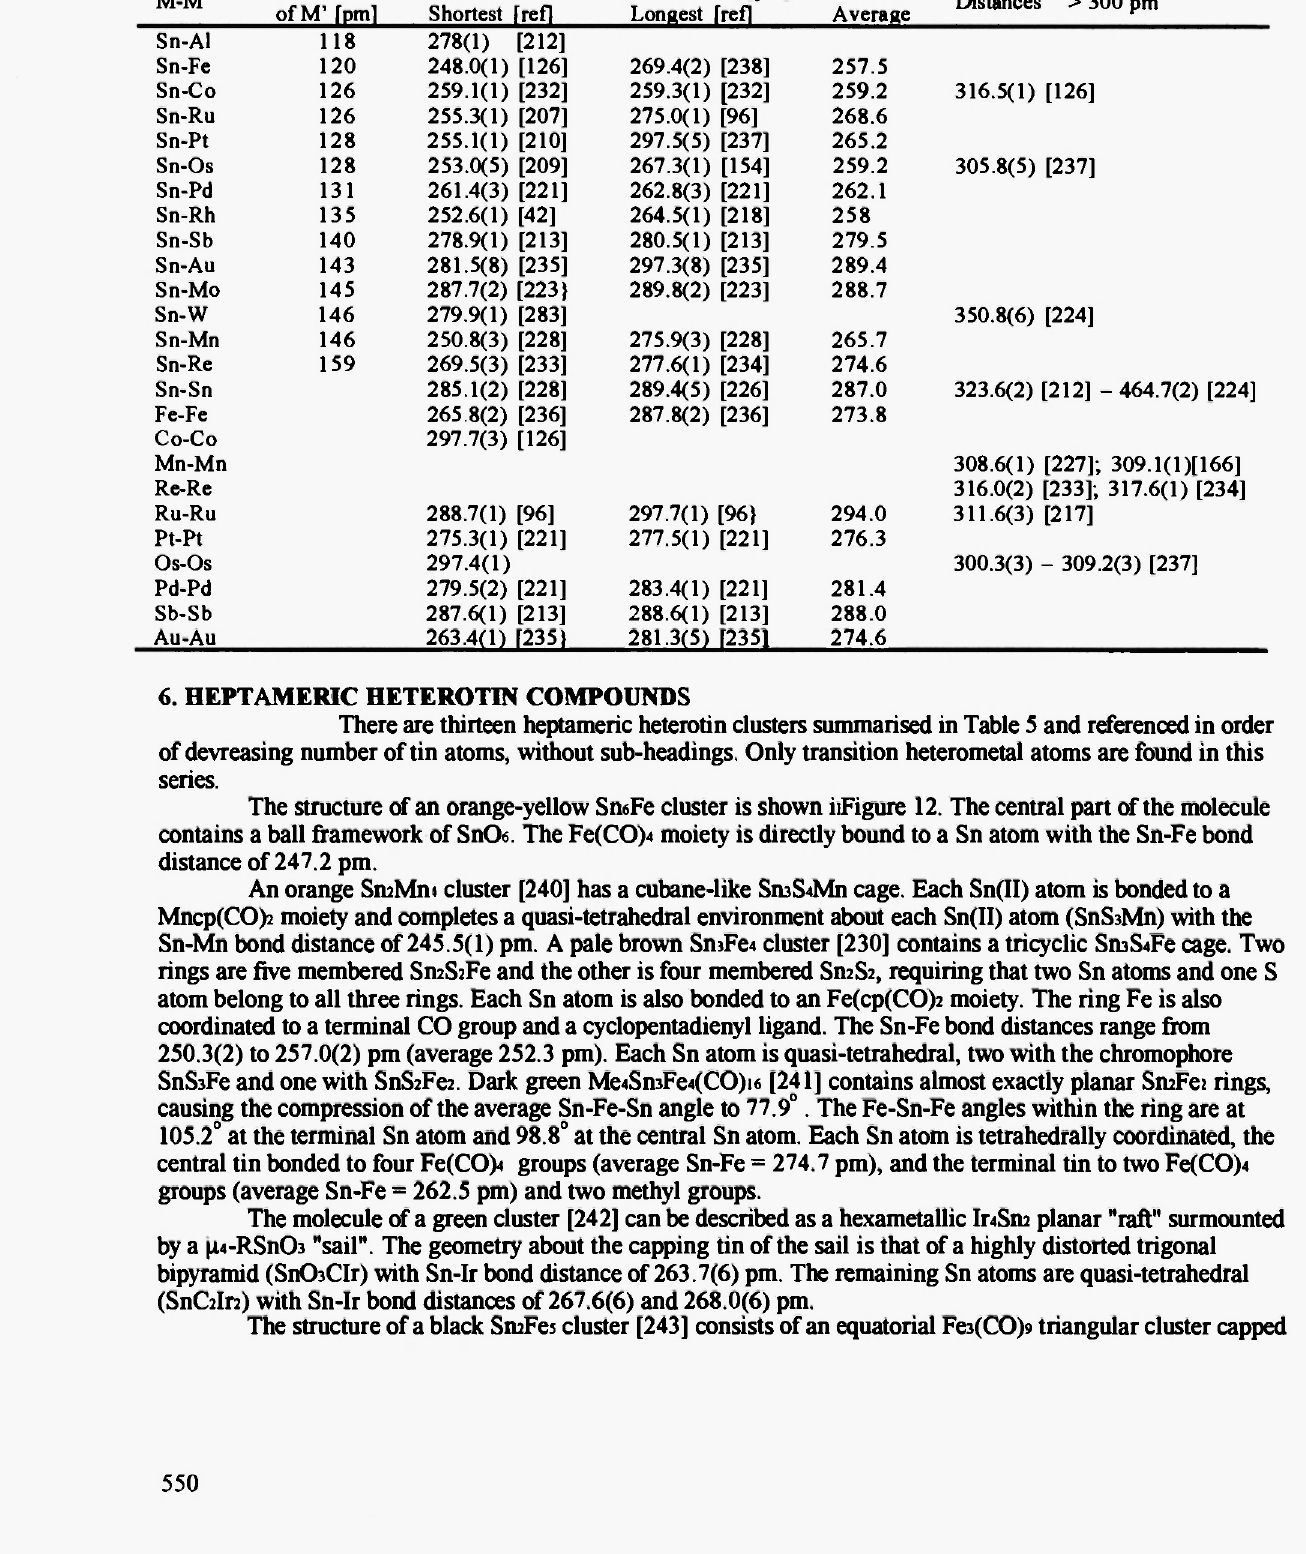
Table 4a. The Sn-Fe bond distance of 248.0(1) [226] is the shortest in the series of hexameric heterotin clusters. Table 4A. Summary of Sn and M-M Distances in Hexameric Heterotin